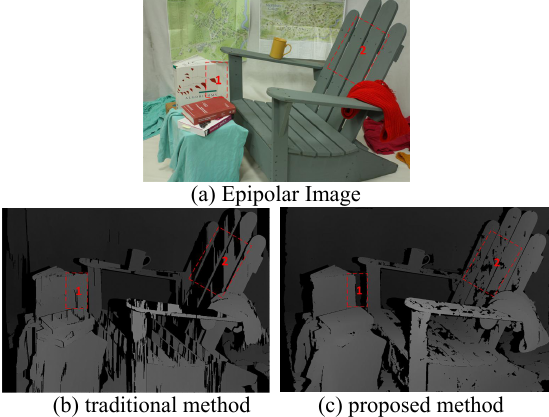
Figure 7. Comparison of Matching in Homogenous